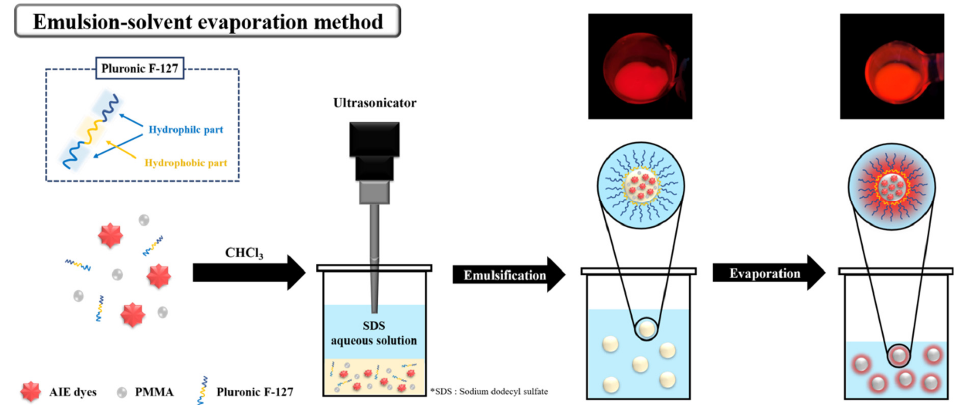
Figure 2. Schematic illustration of DPP ‐ based AIE NPs prepared by emulsion solvent evaporation method.